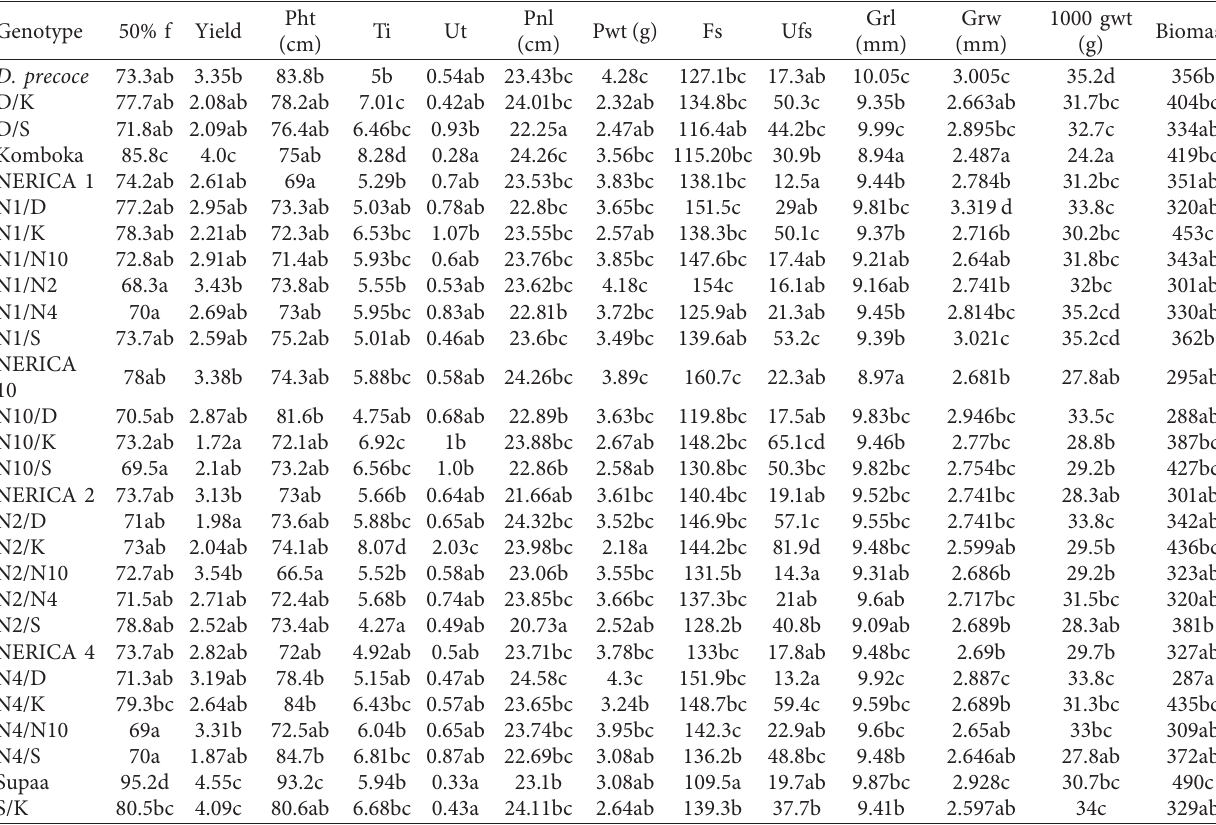
Table 2: Mean performance of genotypes for parents and crosses at KALRO, Mtwapa, and Bahari during the long rain season of 2018.